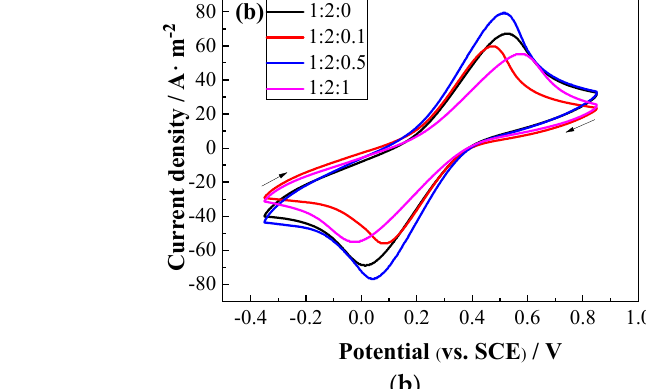
Figure 3. A 3D structure diagram of the 1:2:0.5 TDES.